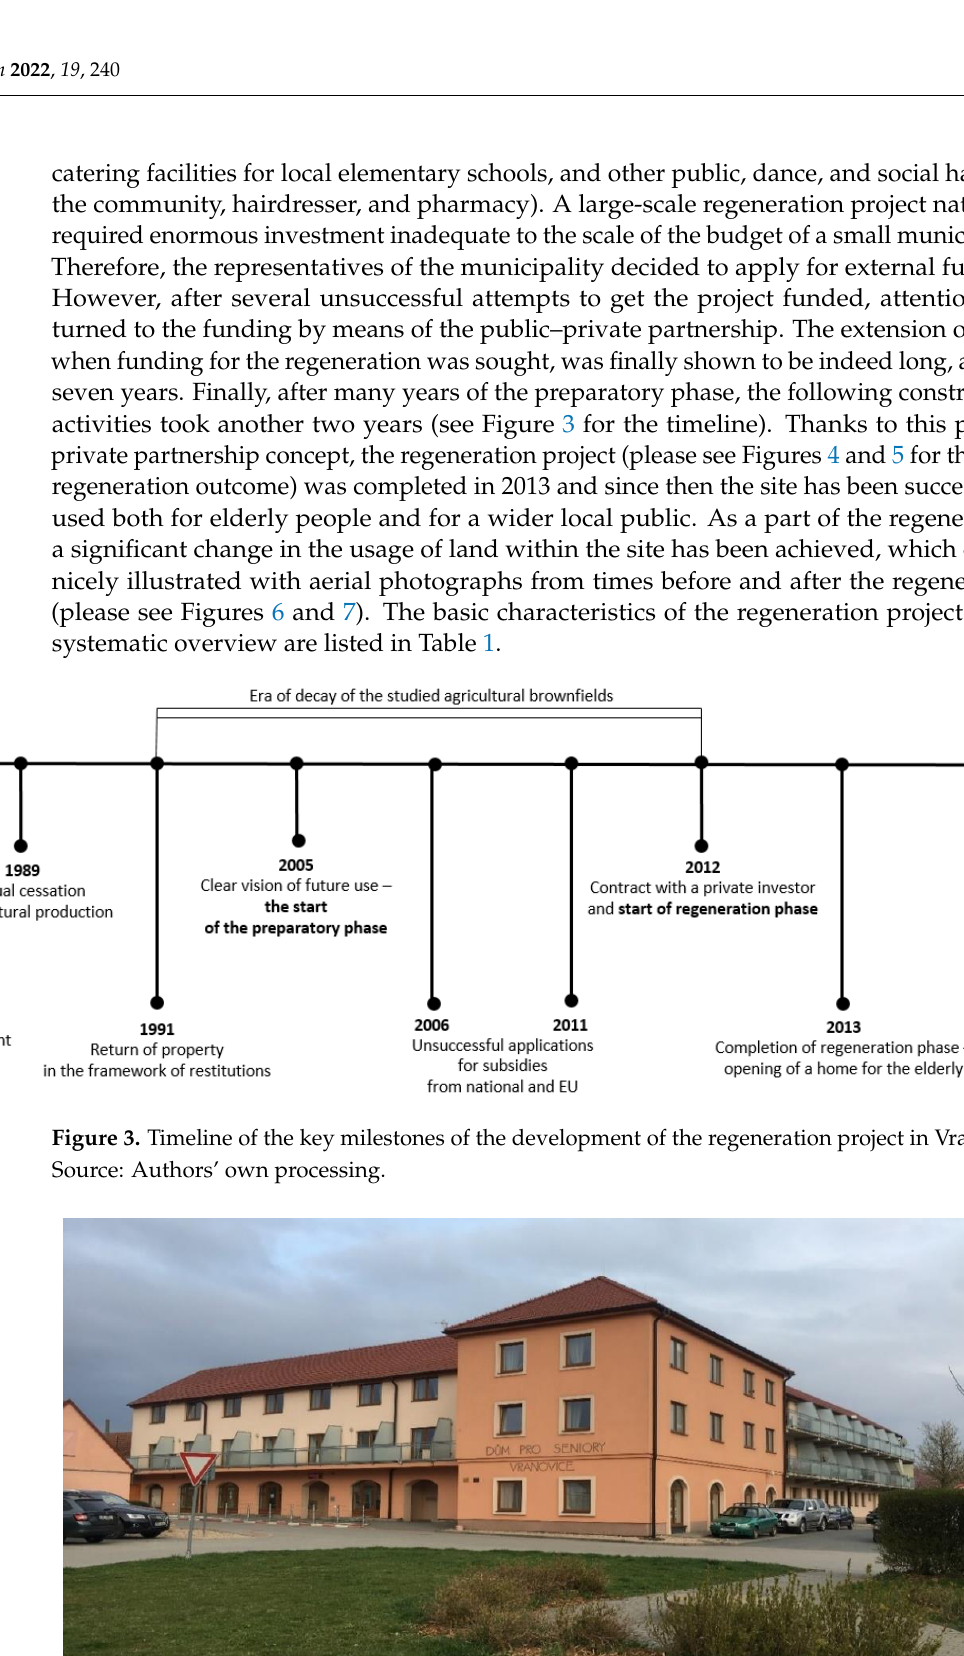
Figure 5. A view of the social care home for elderly people from the courtyard in Vranovice. Source: K. Charvátová (2021). Figure 6. Aerial views of the site of a former agricultural cooperative in Vranovice before regenera- tion in 2003. Source: [60].